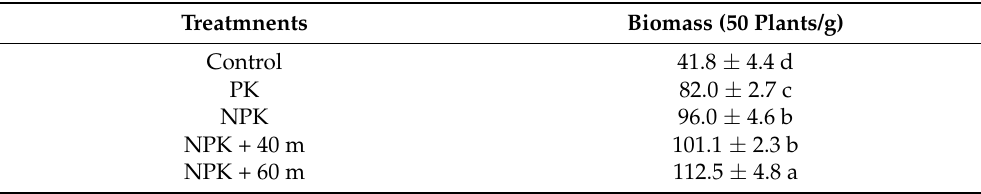
Mean ± SD. Lower case letters represent significant difference between treatments at p <